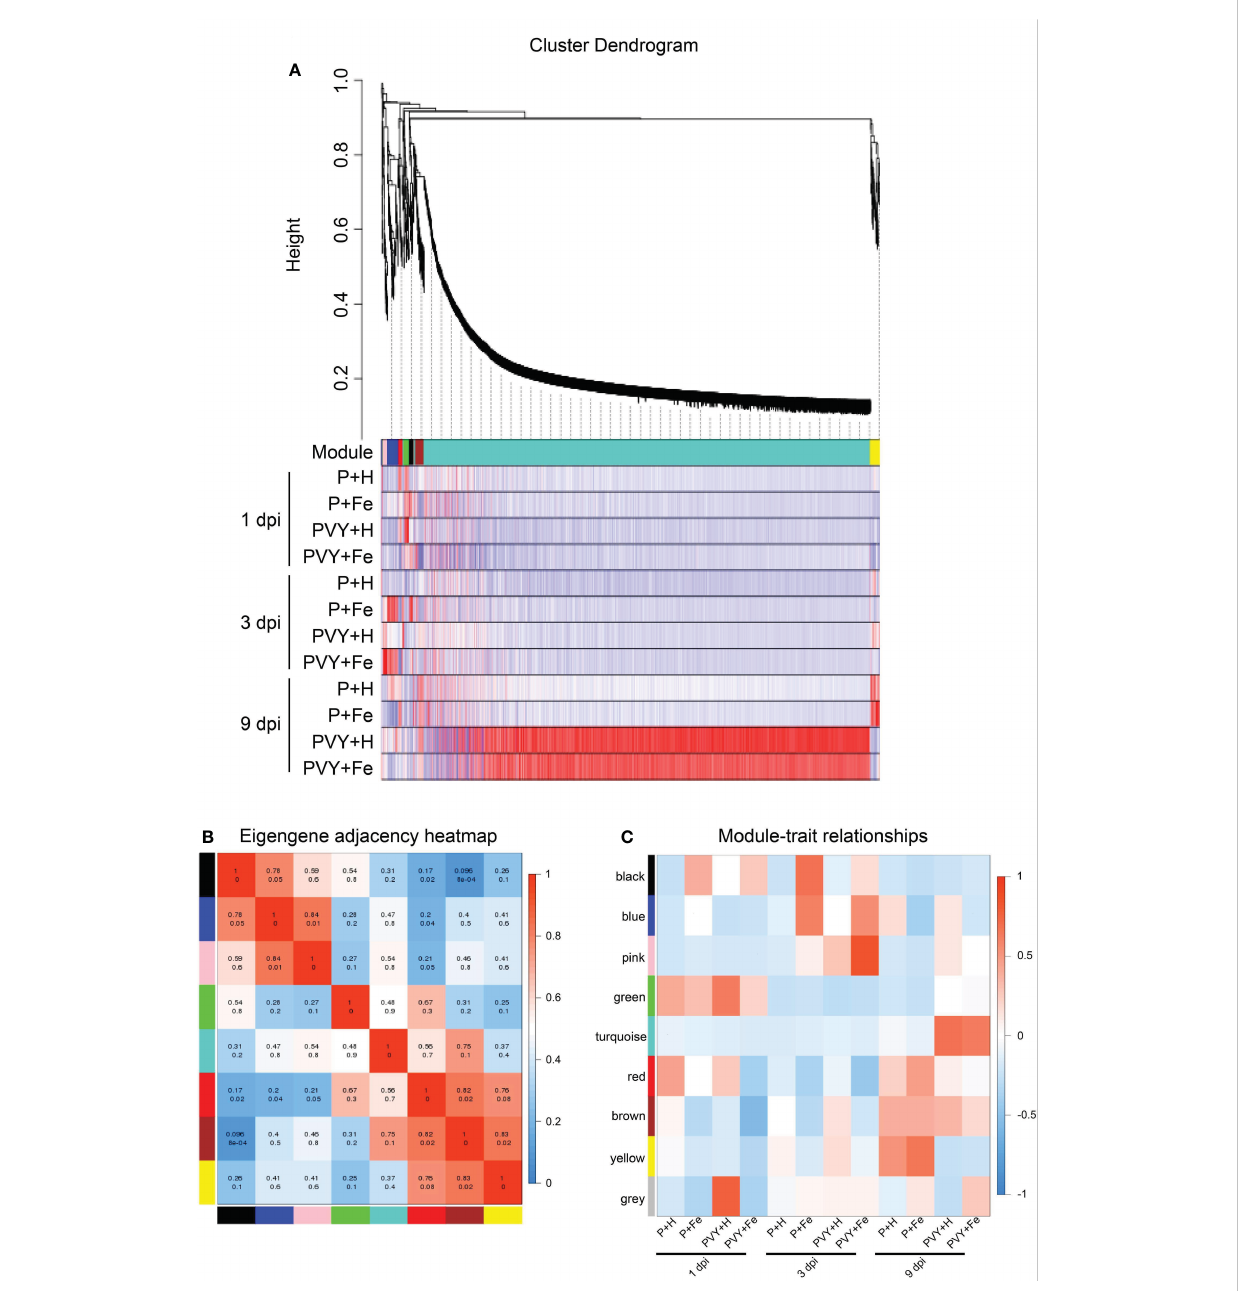
FIGURE 6 Weighted correlation network analysis (WGCNA) of DEGs. (A) Hierarchical cluster tree and heatmap of all DEGs. The hierarchical cluster tree shows co-expression modules identi fi ed through WGCNA. Each leaf in the tree represents one DEG. The major tree branches constitute eight modules labeled with different colors. The heatmap shows the relative expressions of the whole DEGs in different modules. (B) Eigengene adjacency heatmap of the eight modules shows the correlations among different modules. The darker red represents a higher correlation. The numbers in individual cells represent the correlations. (C) Associations between modules and traits. The colors of the modules are the same as that shown in (A, B)